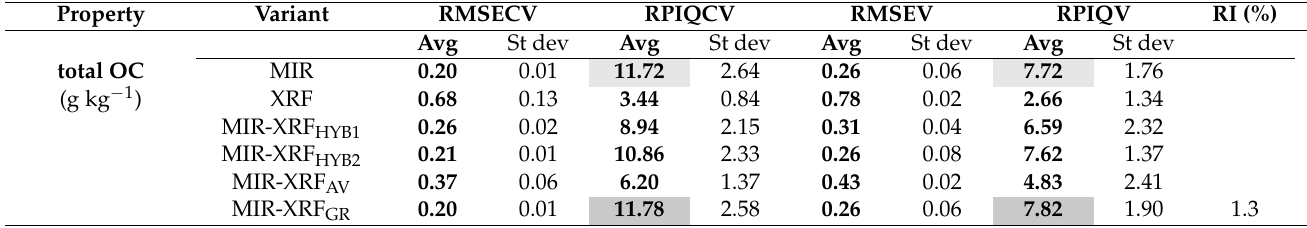
Table 2. Average performance in cross-validation (CV) and validation (V) of model variants for prediction of total organic carbon (OC), N, texture, pH, labile OC, and cation exchange capacity (CEC). See Table 1 for variant definitions. The best single and fusion approaches in training and testing for each property are shaded. RMSE = root mean squared error, RPIQ = ratio of prediction to interquartile distance, RI = relative improvement in